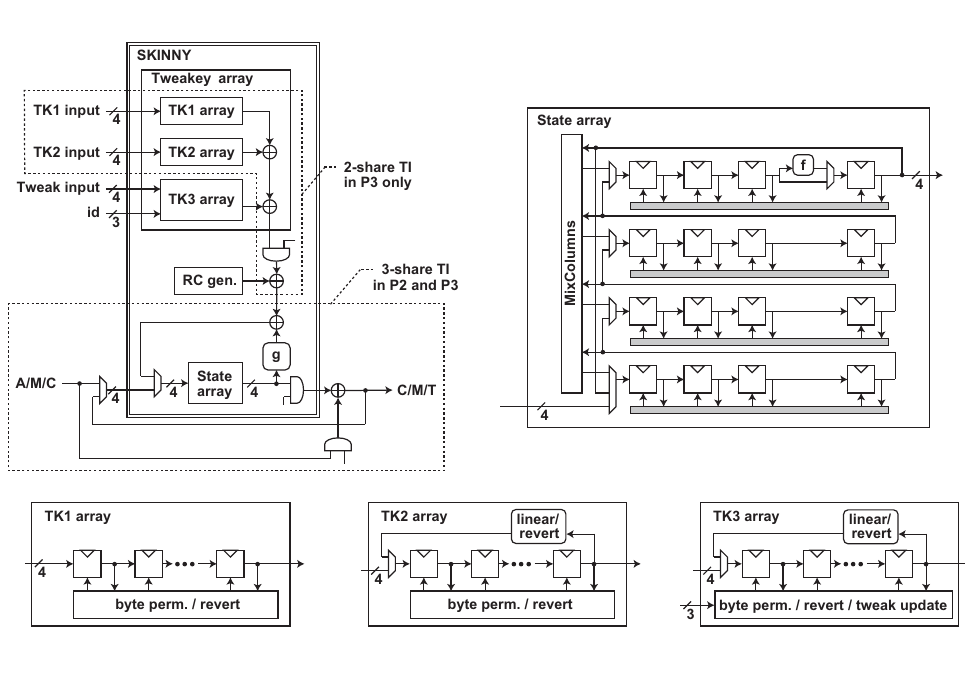
Figure 4: PFB[SKINNY] hardware